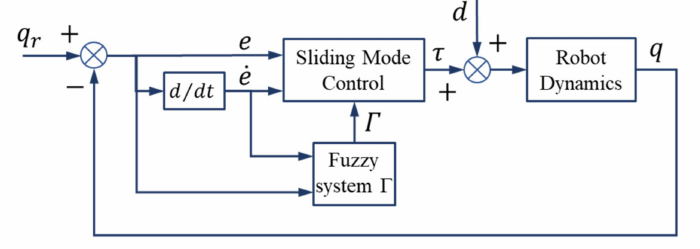
Figure 3. FSMC with adaptive control gains of Γ